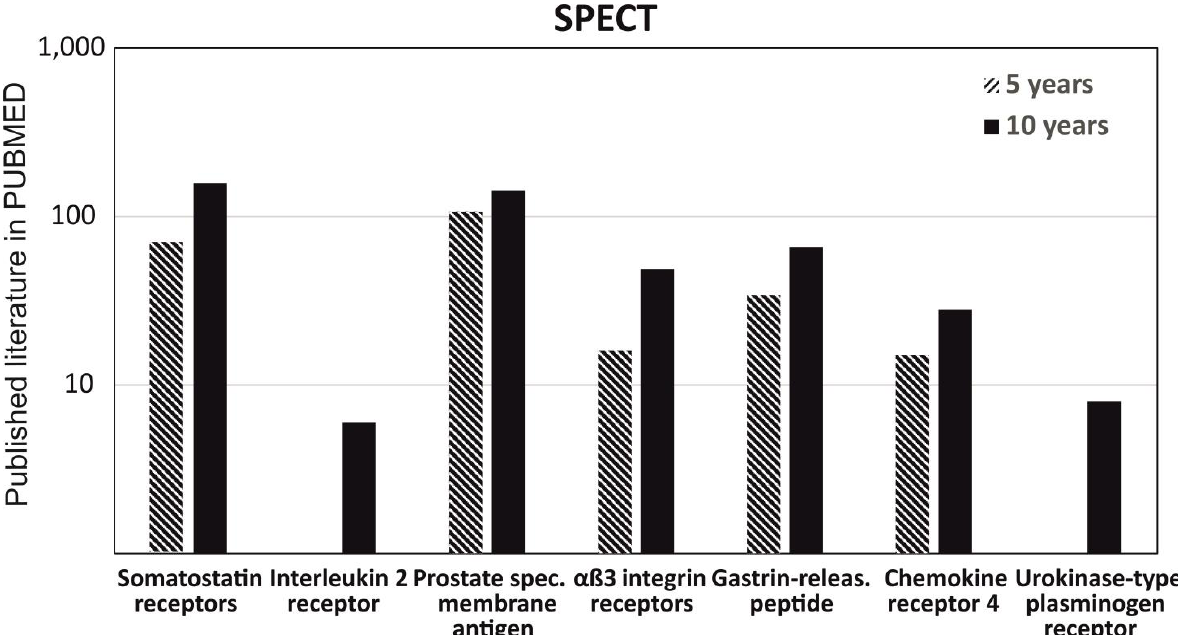
Figure 7. Understanding the role of radiolabeled peptide in SPECT through the published literature on PUBMED in the last 5 years and 10 years. Comparison of the data published with different keywords, such as somatostatin receptors, interleukin 2 receptor, prostate specific membrane antigen, αβ 3 integrin receptor, gastrin-releasing peptide, chemokine receptor 4, and urokinase-type plasminogen receptor.